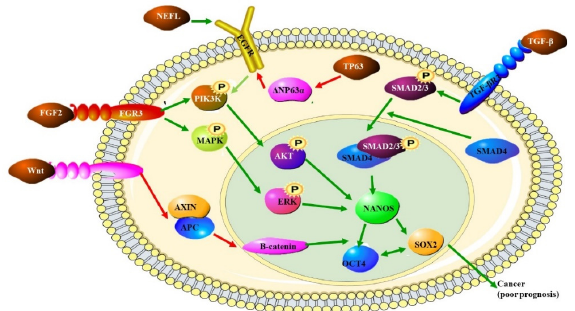
Figure 1. The role of various pathways in OSCC: the transcription factor SOX2, the ligand for the FRIZZLED receptor, WNT and the transcriptional activator TP63 are all up regulated in OSCC. The increased expression of these proteins also indicates a poor prognosis. SOX2 forms a trimeric complex with OCT4 on DNA and NANOS which controls the expression of several genes involved in proliferation. NANOS is a translational repressor which leads to the increased expression of metalloproteinases. Increased WNT expression leads to increased levels of β -catenin. TP63